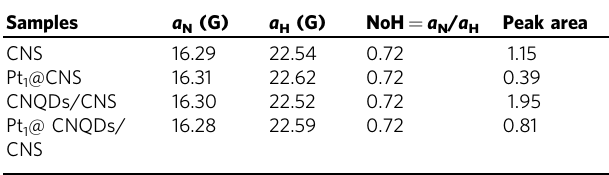
Table 1 Relevant data from simulations of the EPR spectra of DMPO-H